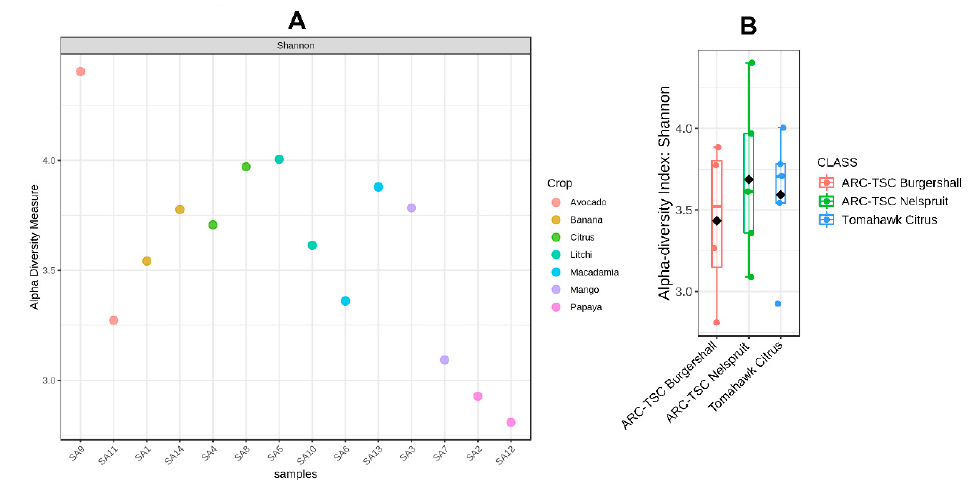
Figure 5. The alpha diversities of the fungal communities associated with 14 subtropical fruit orchards in Mpumalanga province, South Africa, using the Shannon index. ( A ) Table for each sample; ( B ) alpha diversity biplot for three sampling regions.